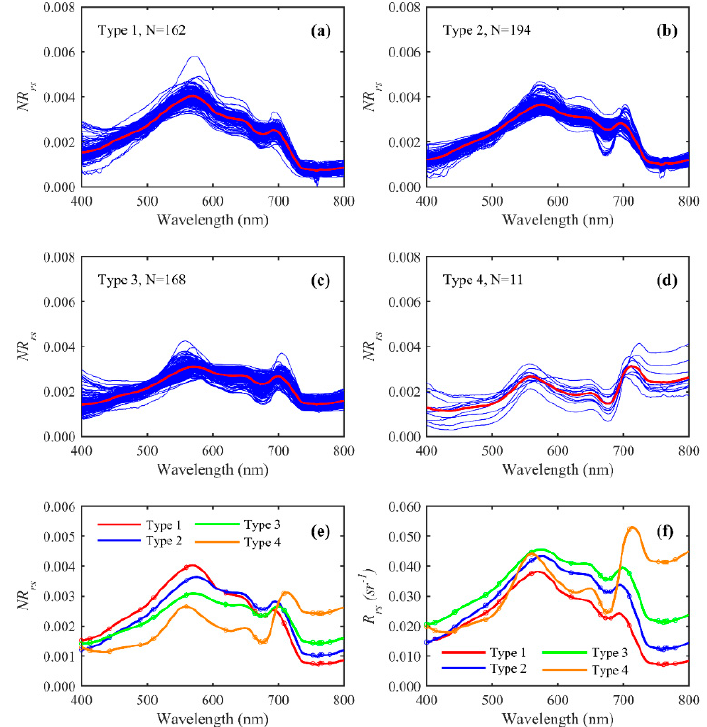
Figure 4. ( a – d ) NR rs ( λ ) sorted into the four optical water types (OWTs) from the k -means cluster analysis ( N = 535); blue lines: individual NR rs ( λ ) values; red lines: mean NR rs ( λ ) of each OWT. ( e ) The mean spectra of NR rs ( λ ) of the four OWTs. The OWT means and covariance matrices are the basis for the membership function. Note that the optical classification was conducted using the NR rs ( λ ) of the field data. ( f ) The mean spectra of R rs ( λ ) of the four OWTs.